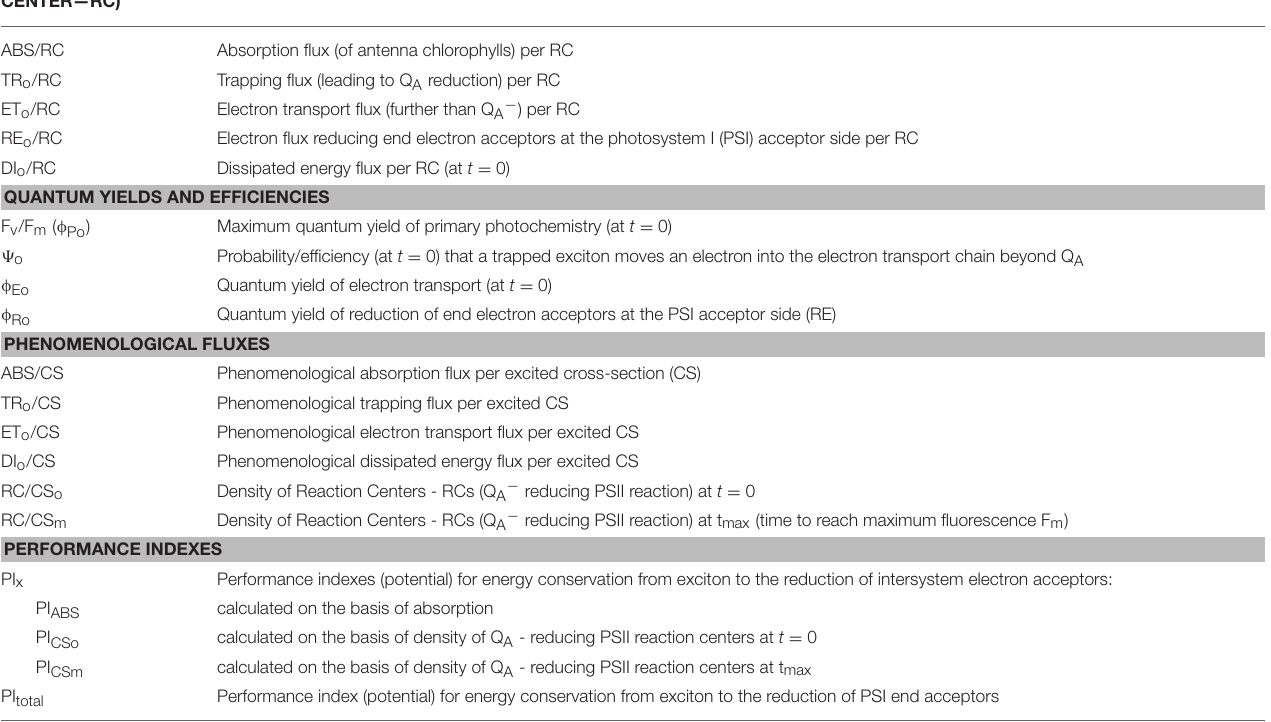
TABLE 1 | OJIP-test parameters calculated in the